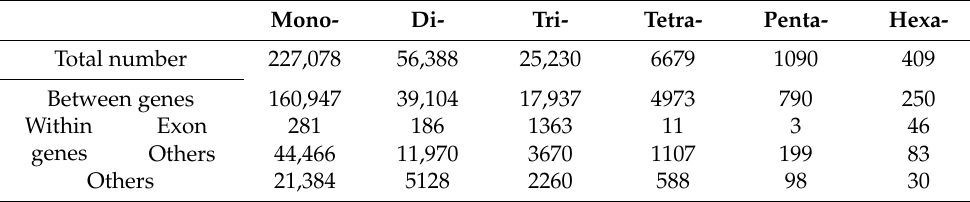
Table 3. Distribution of SSR motif types in the ‘Chardonnay’